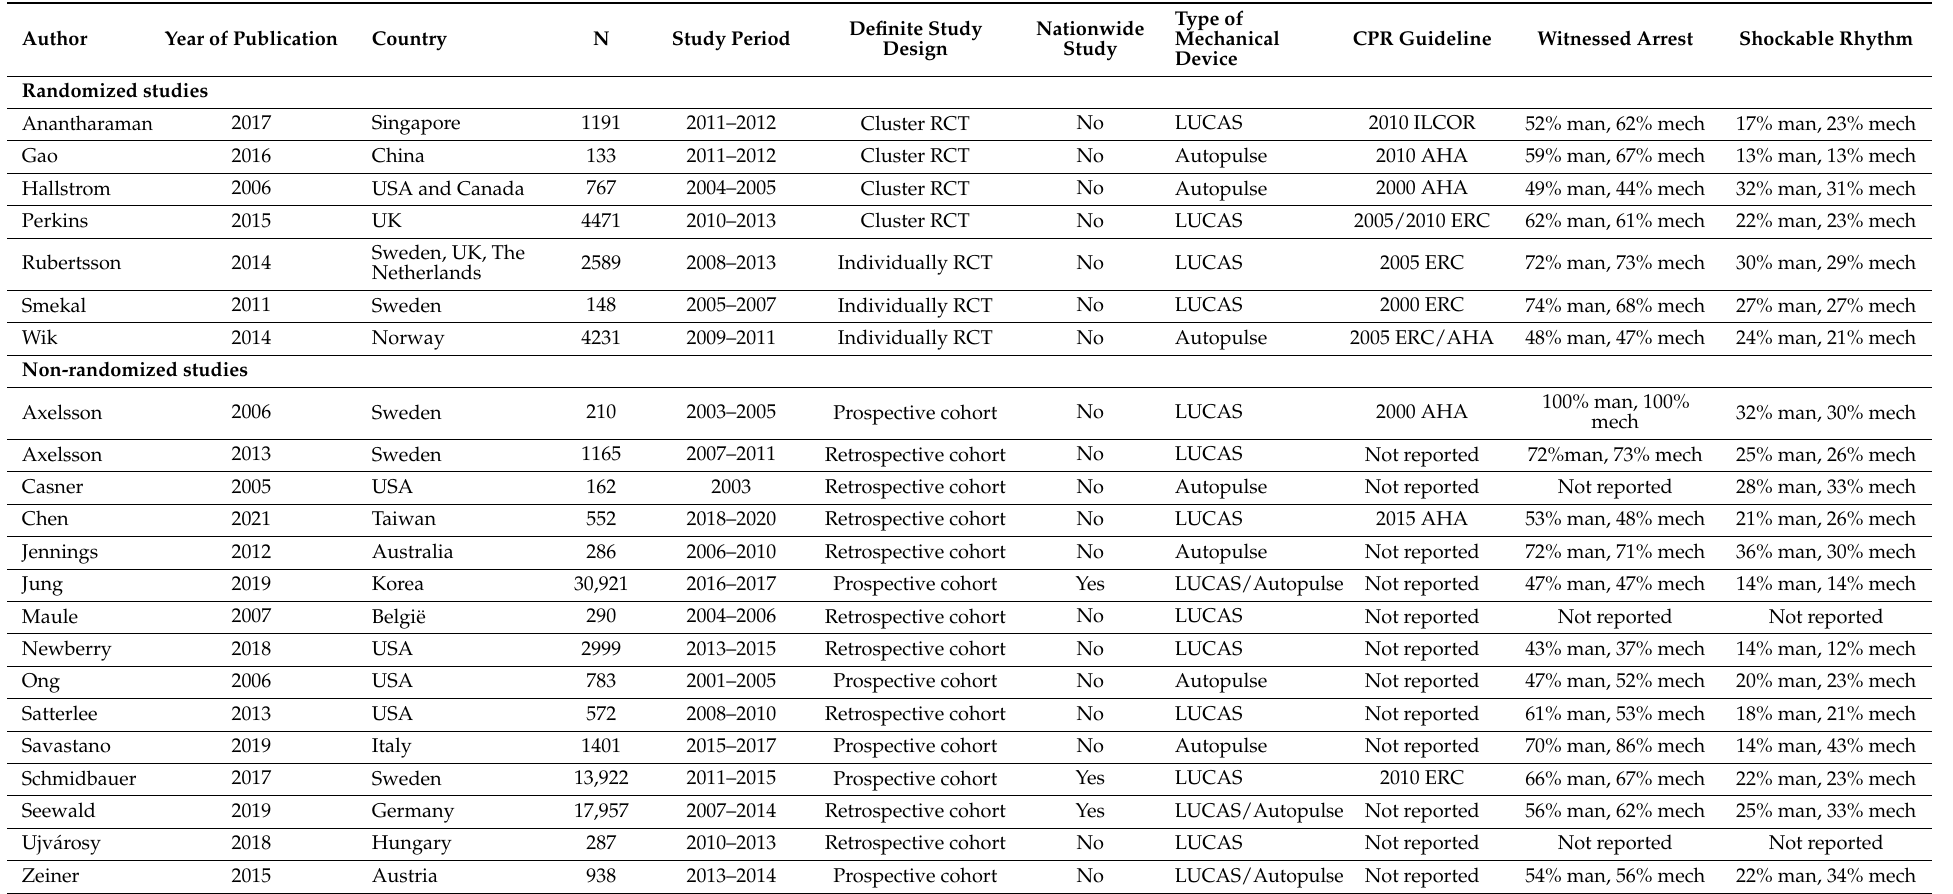
Table 1. Summary of the included